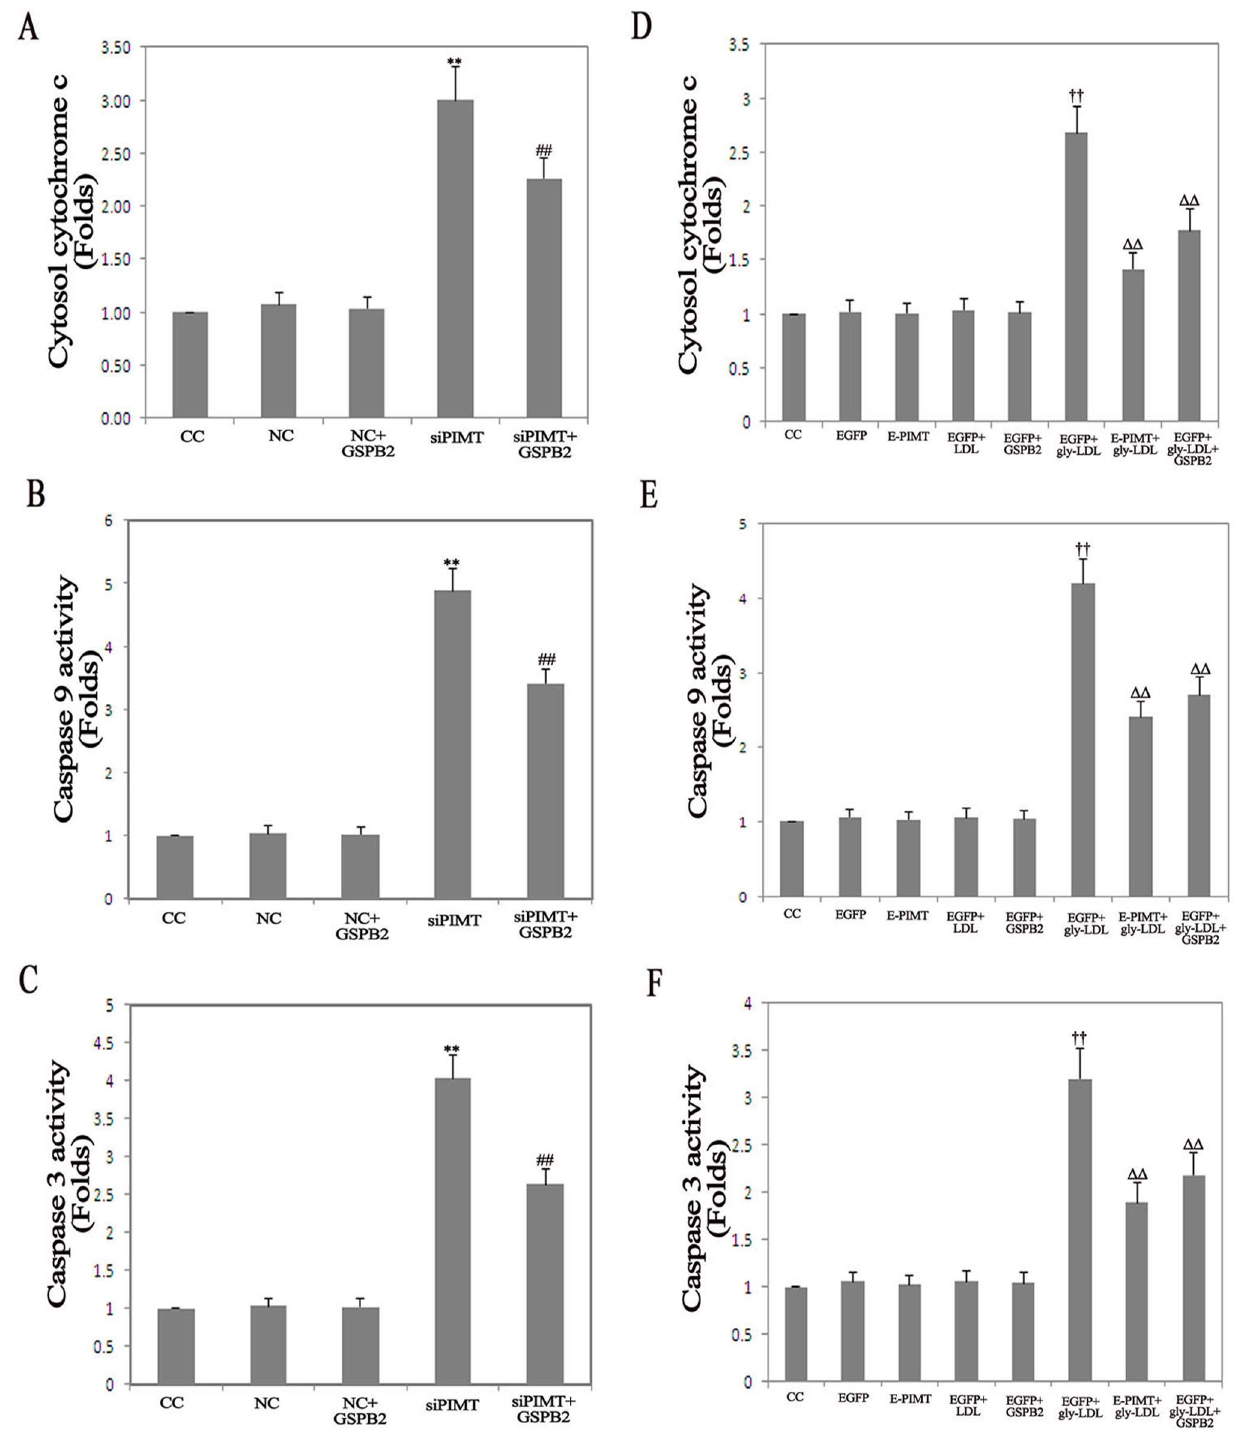
Figure 6. Effects of PIMT on cytosol cytochrome c concentration, caspase-9 and caspase-3 activity in HUVEC treated by gly-LDL. A, B, C: Effects of PIMT siRNA, GSPB2 on cytosol cytochrome c concentration, caspase-9 and caspase-3 activity in HUVEC. D, E, F: Effects of PIMT overexpression, GSPB2 on cytosol cytochrome c concentration, caspase-9 and caspase-3 activity in HUVEC treated by gly-LDL. * P , 0.05, ** P , 0.01 compared with NC group; # P , 0.05, ## P , 0.01 compared with siPIMT group. { P , 0.05, {{ P , 0.01 compared with EGFP group; D P , 0.05, DD P , 0.01 compared with EGFP + gly-LDL group.